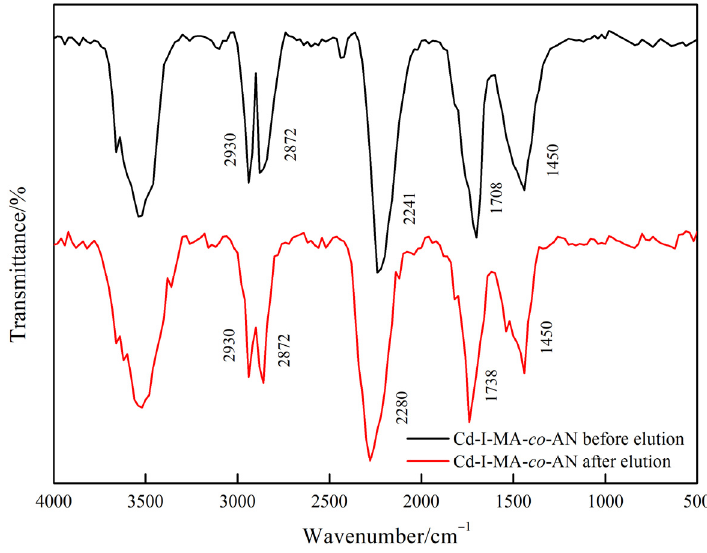
Figure 3. FTIR spectrum of Cd-I-MA- co -AN before and after elution.